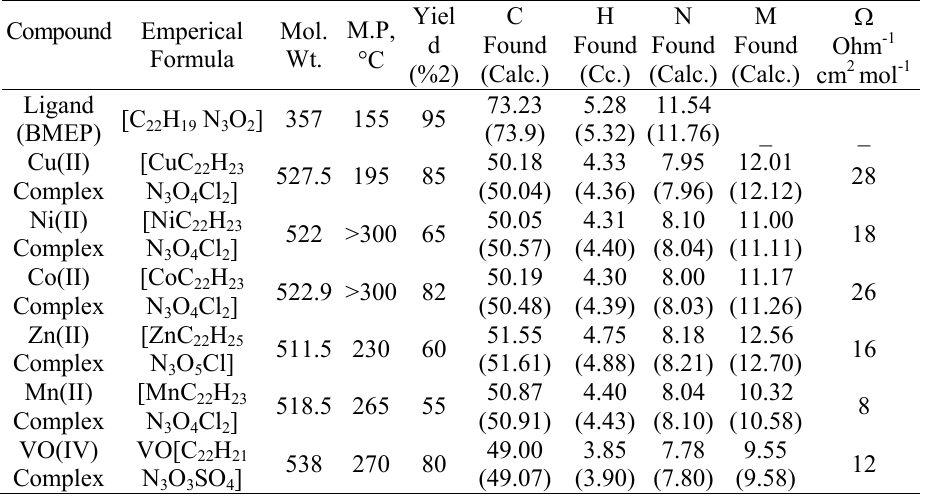
Table 1. Analytical data and physical properties of the ligand and its complexes.